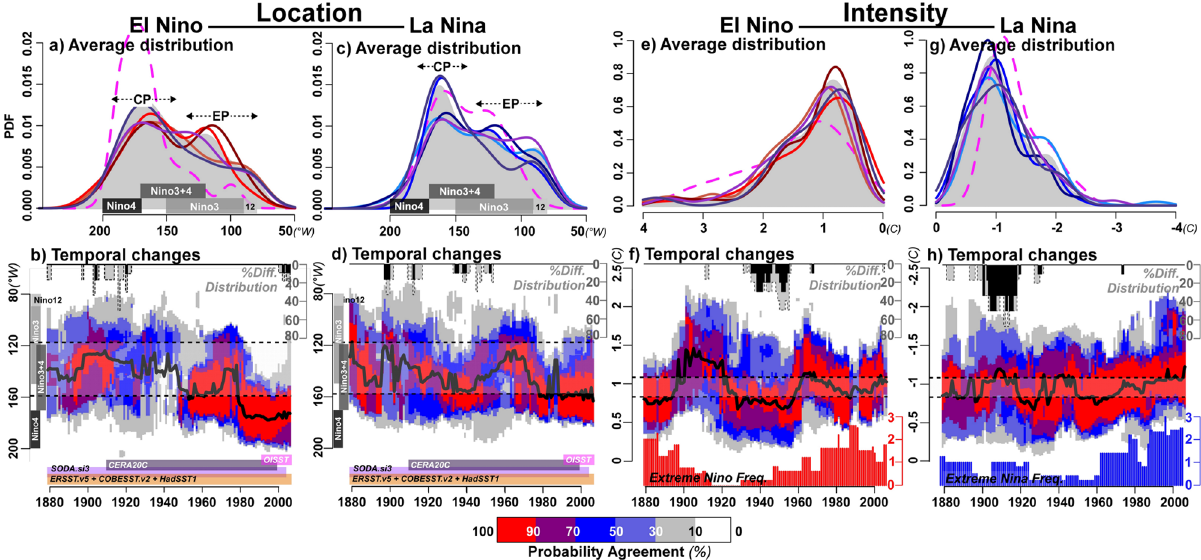
Fig. 2 Observed likelihood of ENSO ’ s location and intensity: average distribution and temporal changes. a Average probability-density function (PDF) of El Niño location. b Twenty-year running most likely location of El Niño (black bold lines), the percentage of agreement of high probability (i.e., PDF exceeding 0.01 and 0.45; colour shades)across all observational datasets. c , d Same as ( a , b ) but for La Niña, and extreme La Niña events (i.e., intensity lower than the 10 th percentile; blue histogram). e – h Same as ( a – d ) but for El Niño and La Niña intensity, and average number of extreme Niño and Niña events (i.e., intensity exceeding the 90 th percentile; red histogram). On panels ( a ), ( c ), ( e ), and ( g ), dark-grey shading from the top axis indicates the average PDF over all six reference SST datasets, and each individual dataset is displayed in coloured lines (El Niño/La Niña: ERSST.v5 [1850 – 2018; coral/ light blue], COBESST.v2 [1850 – 2018; dark red/dark blue], HadSST1 [1850 – 2018; red/blue], SODA.si3 [1850 – 2015; purple solid lines], OISST.v2 [1981 – 2018; magenta dashed lines], CERA20C [1901 – 2010; darkochid solid lines]). On panels ( b ), ( d ), ( f ), and ( h ), grey (black) histogram indicates the percentage of observational datasets showing signi fi cantly equal distribution at p = 0.1 (0.05) according to a Kolmogorov – Smirnov test. Dashed lines and grey shading indicate the range of variability that could be obtained in a random fi eld at p = 0.05. Locations of Niño boxes, as well as of the date line, are indicative. Coloured boxes delineate the period for which each dataset is